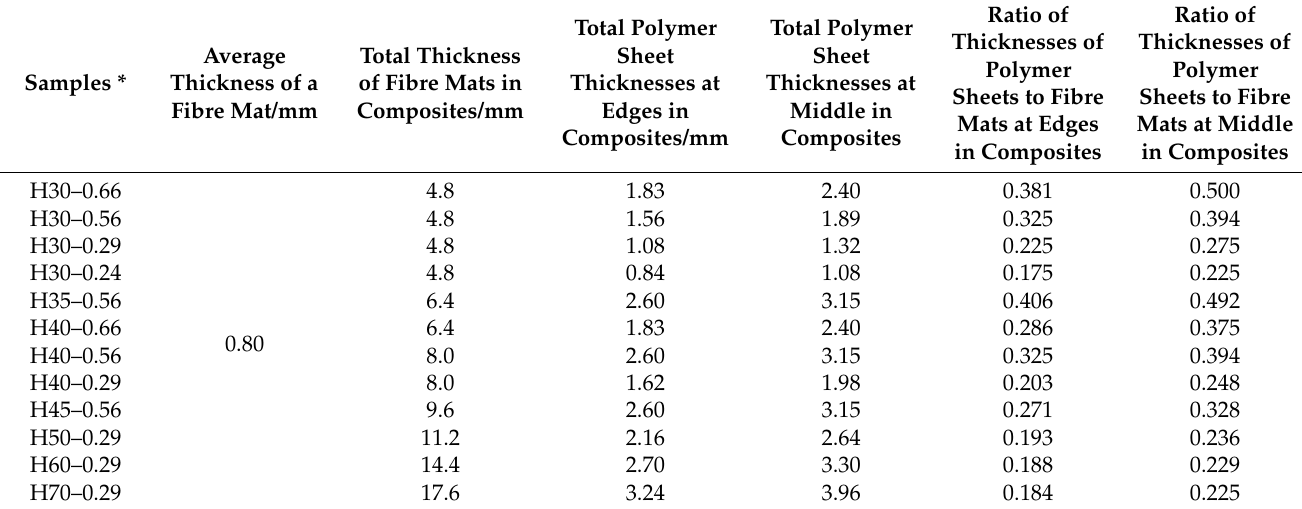
Table 3. Ratio of thicknesses of polymer sheets to fibre mats in composites.